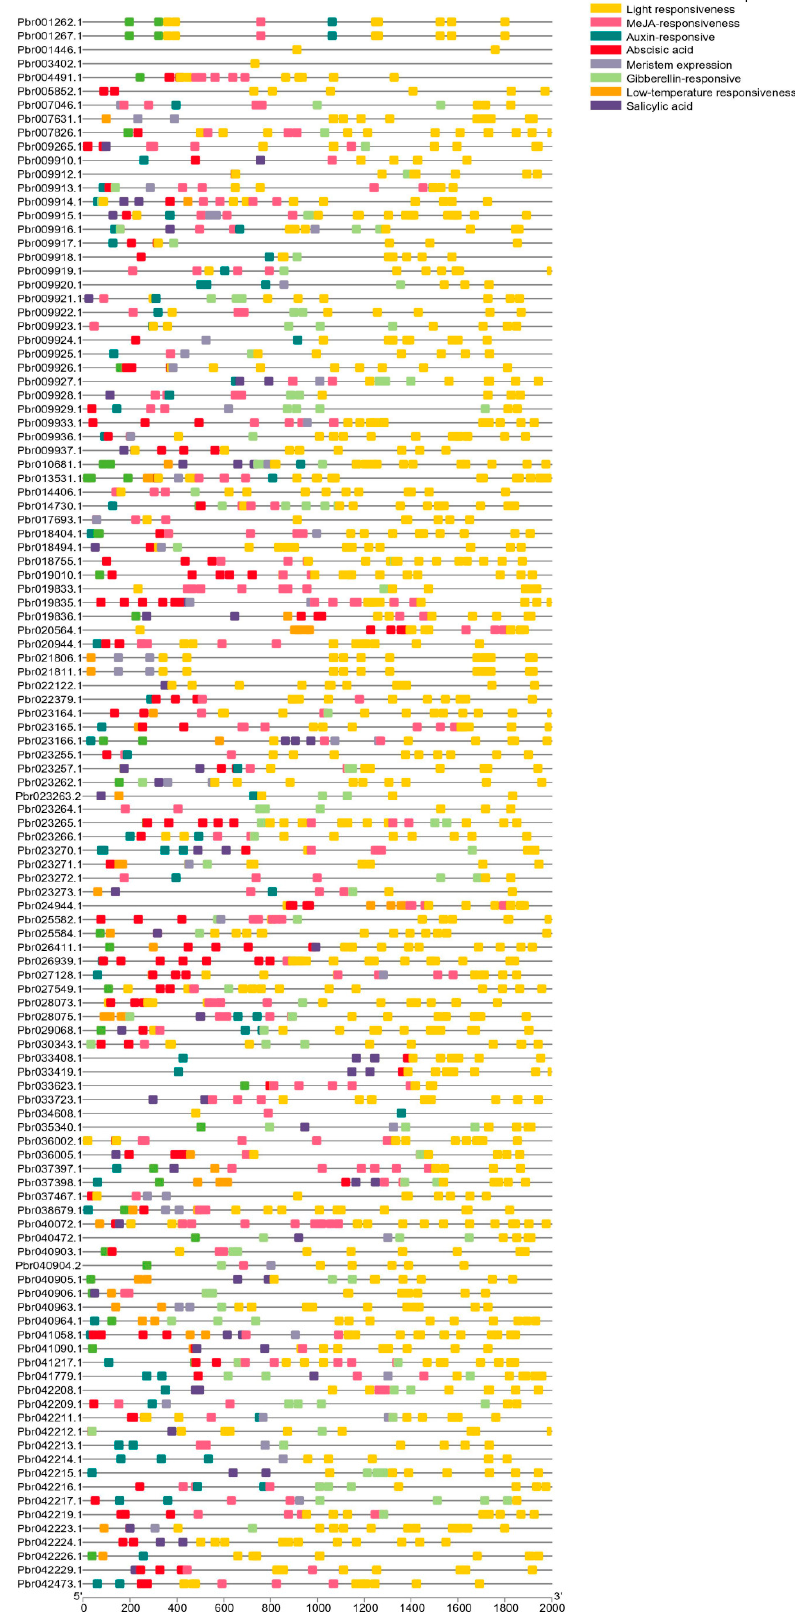
Figure 3. Promoter Cis -elements of the 116 PbrSAURs .